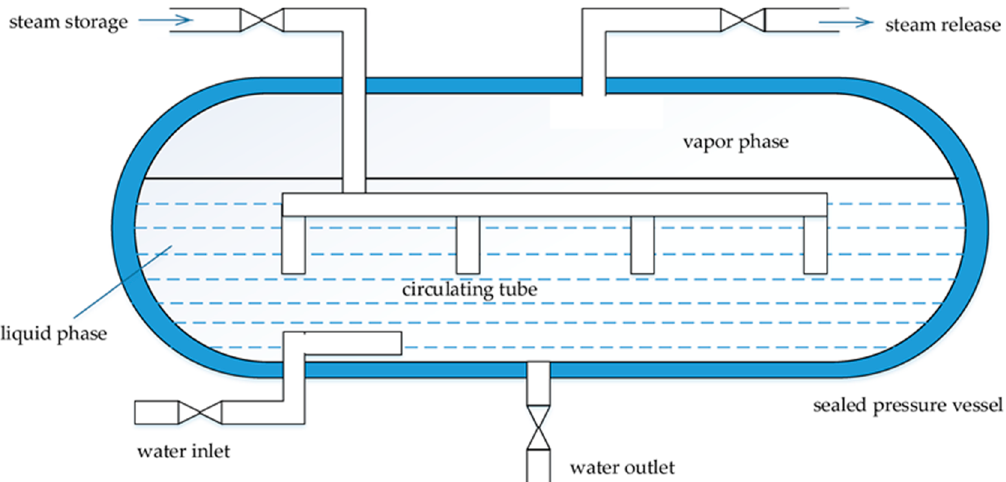
Figure 1. Schematic layout of a steam accumulator (SA).